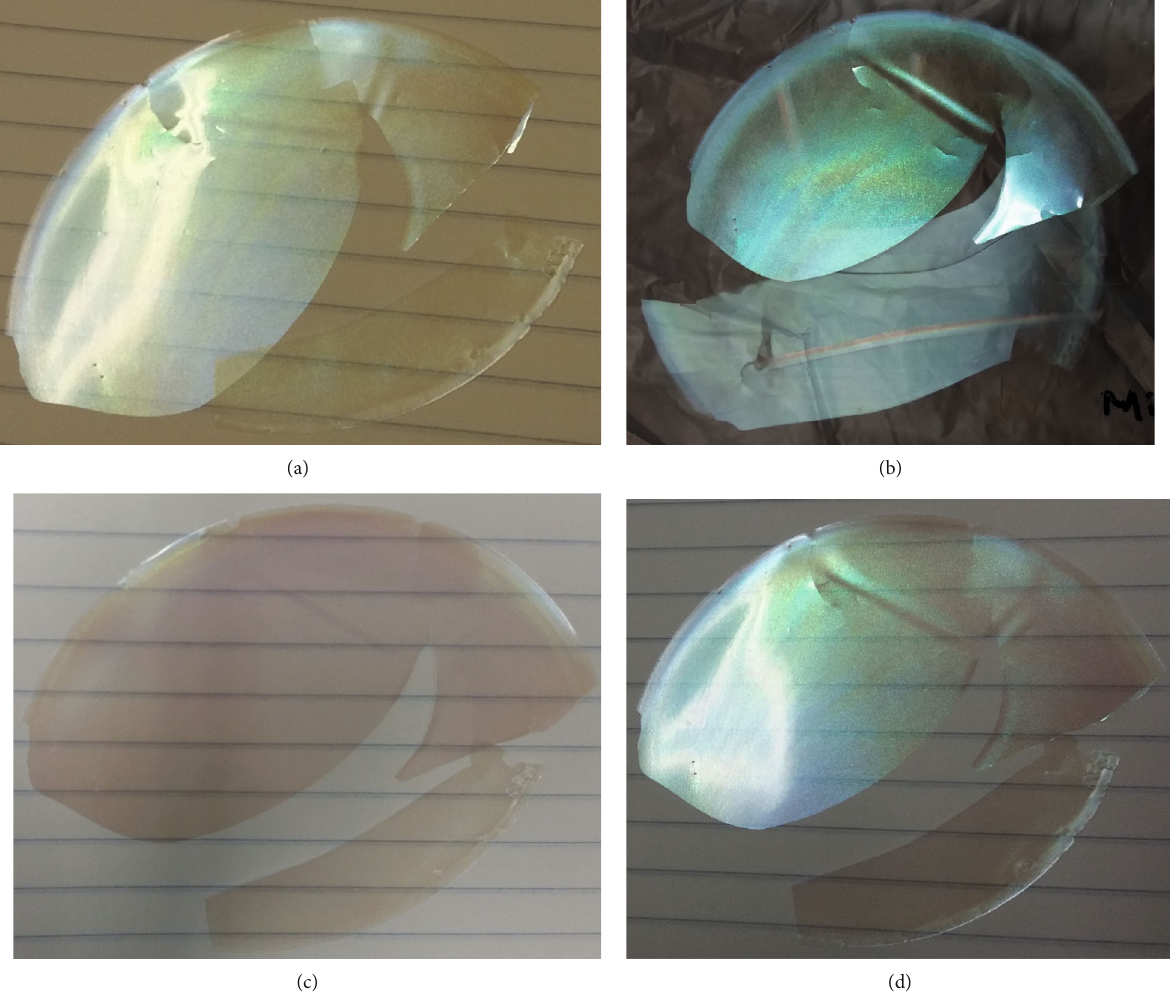
Figure 7: CNC fi lm. The fi lm has iridescence (a, b, and d), and the colour of the fi lm changes when the angle of the light is changed (c, d). The lines on (c, d) are a reference to see the angle of the picture.